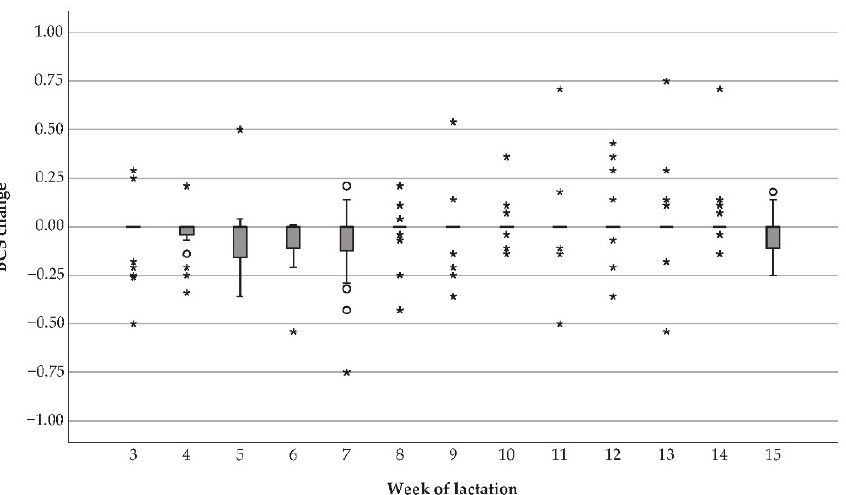
Figure 4. BCS change between two weeks of dairy cows ( n = 28) between week 2 and 15 postpartum (p.p.). In each subfigure, the boxplots respectively highlight the median, upper, and lower quartiles of each week. Box whiskers extended to the most extreme nonoutlier data points were considered as outliers if they lay more than 1.5 times the interquartile range from the edge of the box. Small circles = outliers (1.5 × interquartile range (IQR)); asterisks = extreme values (3 ×